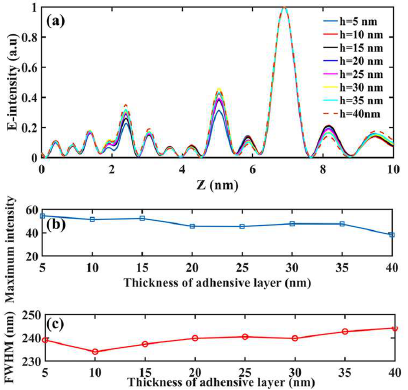
Figure 6. The changing rules of ( a ) the focusing properties, ( b ) the maximum intensity of the main hotspot, and ( c ) the FWHM with the increased thickness of adhesive layer.